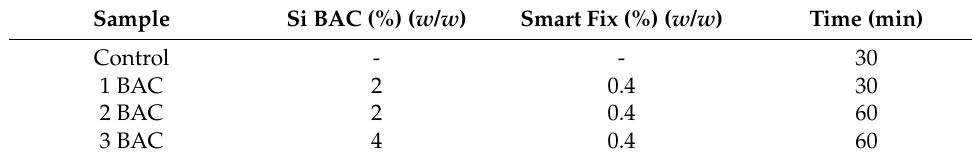
Table 2. Conditions used in the antimicrobial finishing of BC composites.